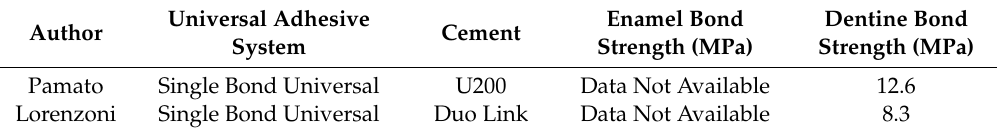
Table 6. Bond strength of universal adhesive systems